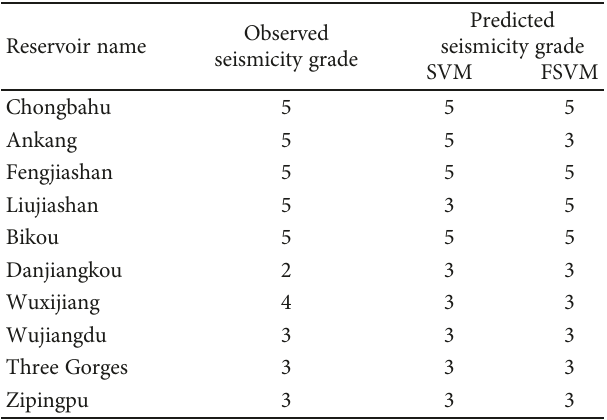
Table 12: Prediction results of RTE with group 1. Reservoir name